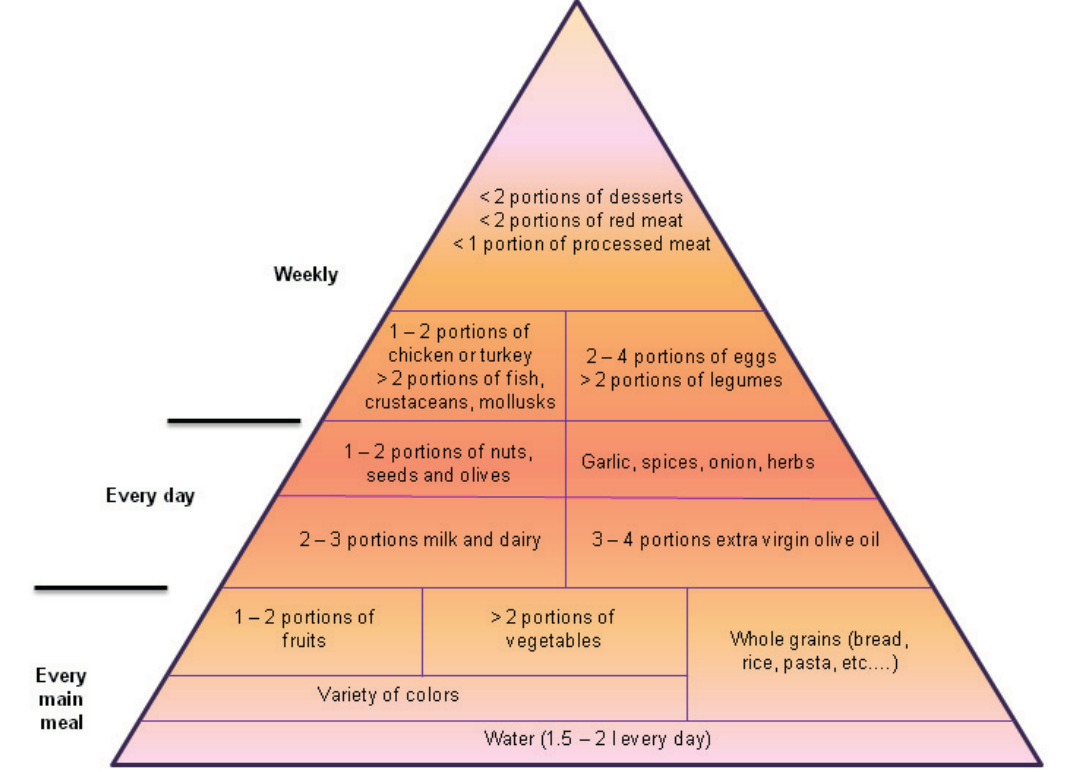
Fig. 3. Food pyramid with daily and weekly consumption of food groups. The Mediterranean food pyramid summarizes the food groups that should be eaten within a week. At the base of the pyramid, we find that water should be consumed daily in large quanti- ties (at least 1.5 l per day). Second to water, fruits, vegetables and whole grains should be consumed daily at every meal. Climbing further, we find herbs, extra virgin olive oil and dairy products, which should be consumed daily. At the top of the pyramid, we find animal products (fish, eggs and meat) and vegetables proteins, the consumption of which should be alternated and weekly. Finally, at the apex of the pyramid are the processed meats and sweets, whose consumption should be